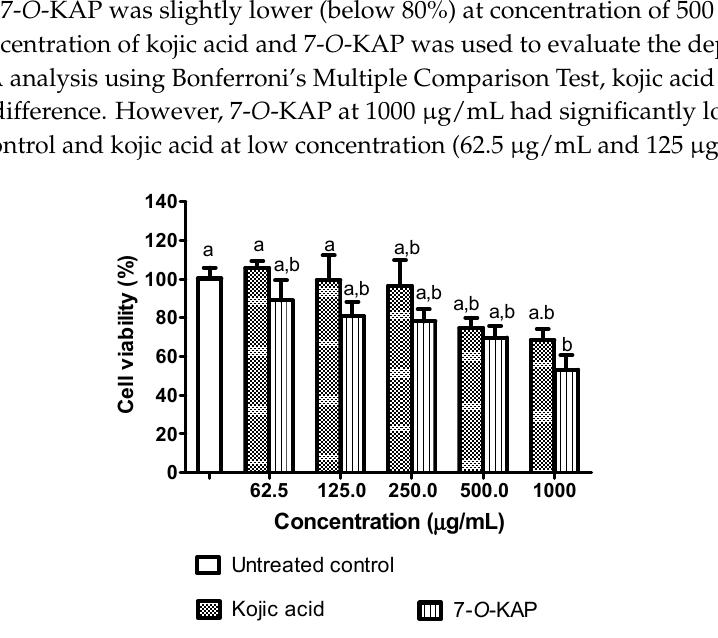
Figure 7. The effect of kojic acid and 7- O -kojic acid monopalmitate (7- O -KAP) on the cell viability of G361 human melanoma skin cells. The cells were treated with various doses of kojic acid and 7- O - KAP (7.81–250 μ g/mL) for 72 h and were examined by MTT assay. Data are presented as means ± (7.81–250 µ g/mL) for 72 h and were examined by MTT assay. Data are presented as means ± S.E.M S.E.M and expressed as % of untreated control, n = 3. The letters a and b indicate significant difference at p < 0.05 with Bonferroni’s Multiple Comparison Test. 0.05 with Bonferroni’s Multiple Comparison